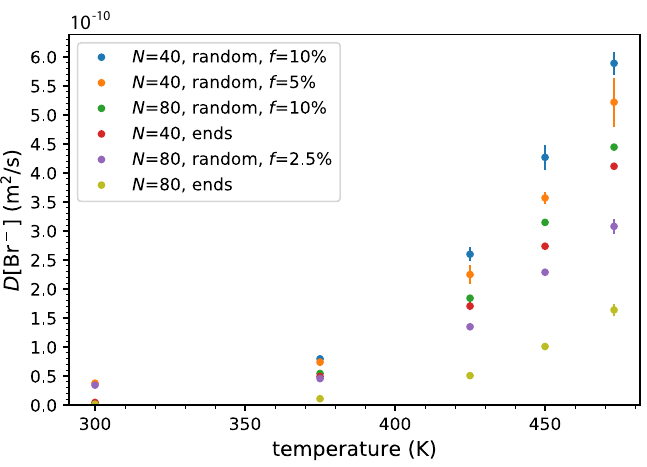
Figure 6. Bromide diffusion coefficient D versus temperature for end- and randomly grafted func- tionalized ionic PDMS